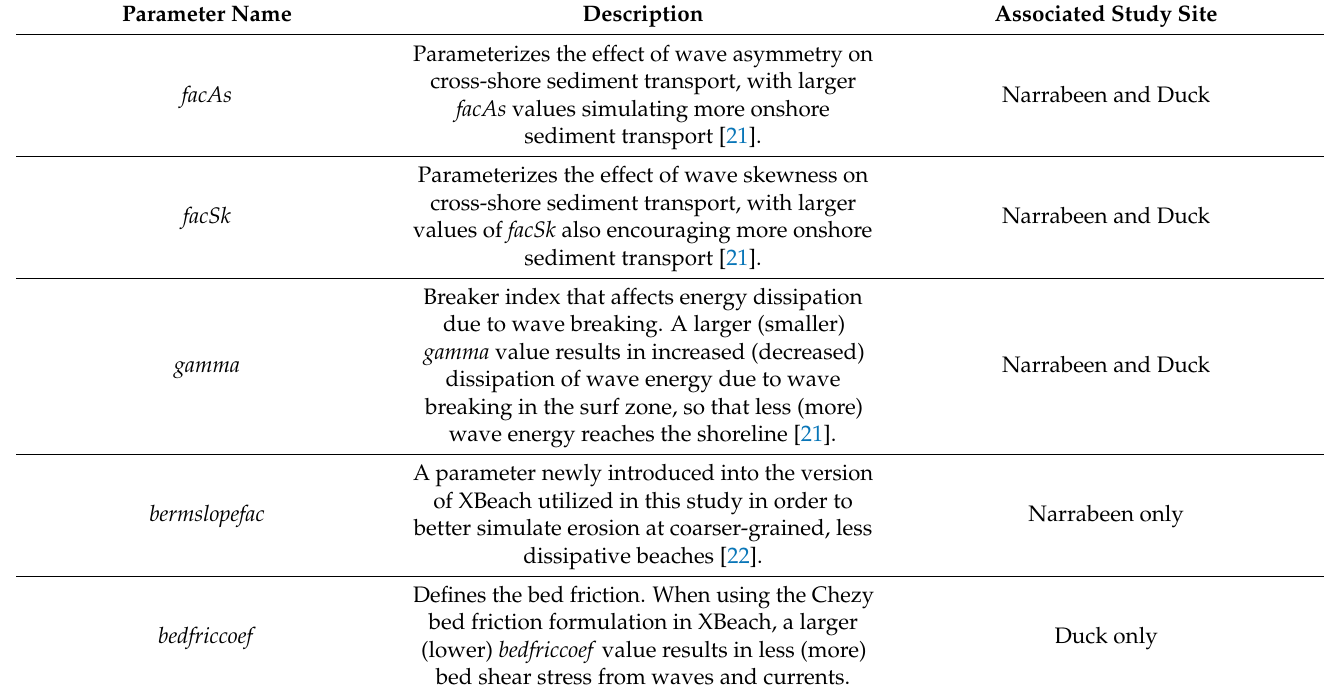
Table 2. XBeach parameters used for model calibration at each study